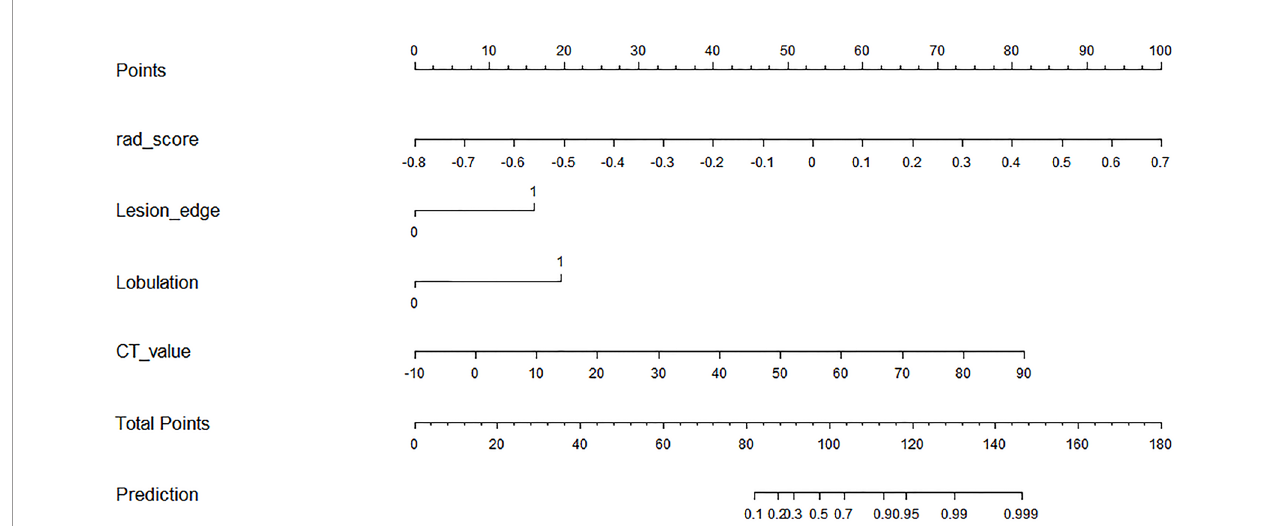
FIGURE 3 | Radiomics nomogram with Rad-score and three conventional CT fi ndings, including lesion edge, lobulation, and CT value.